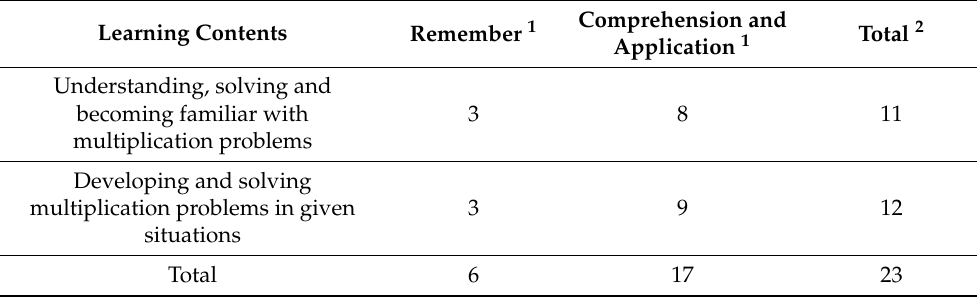
Table 2. Two-way chart of the mathematics learning achievement